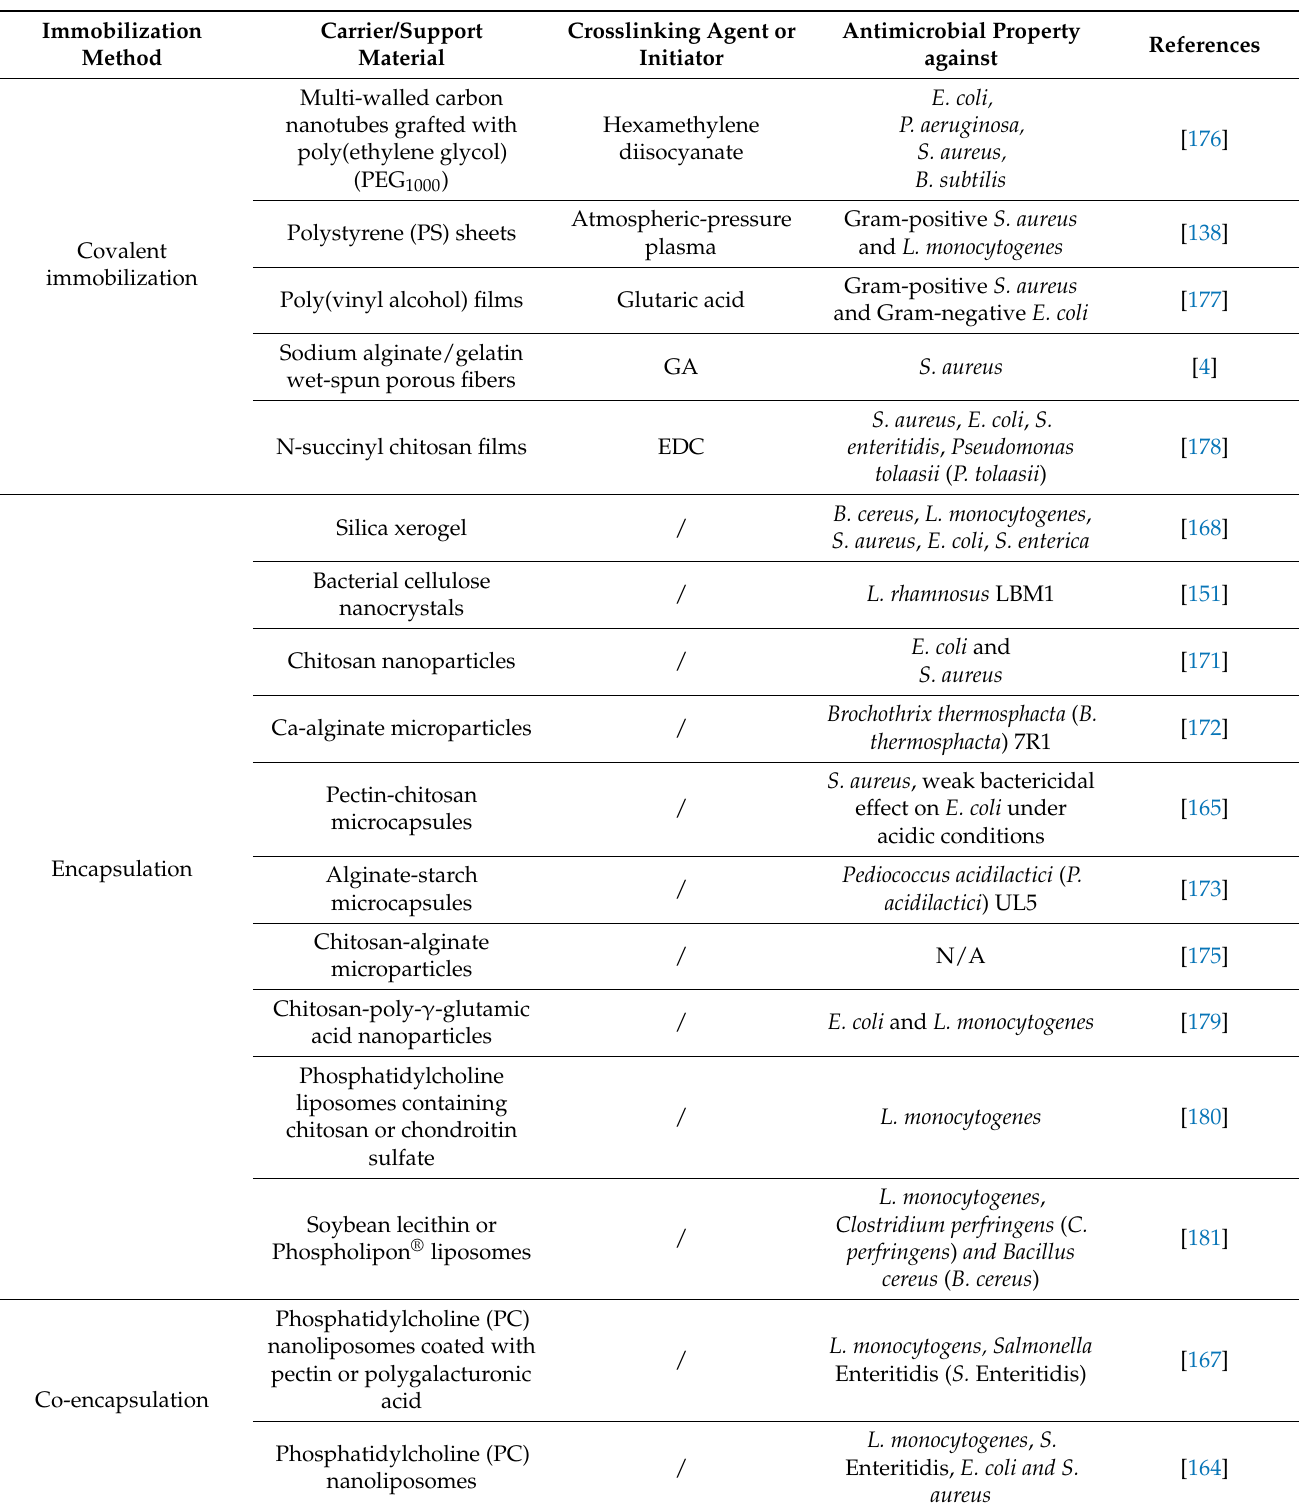
Table 4. Immobilization methods of nisin and antimicrobial activity against Gram-positive and Gram-negative